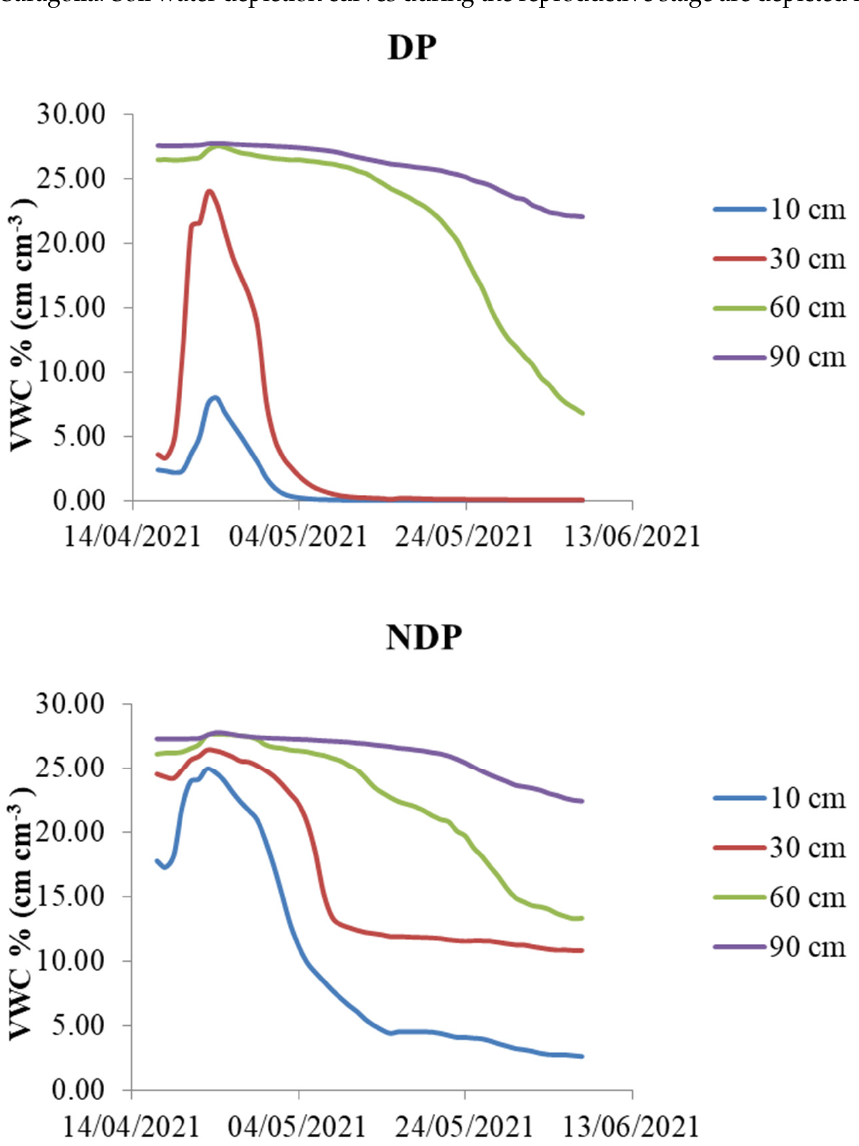
Figure 5. Volumetric water content % (VWC cm cm − 3 ) during the reproductive stage under dual- purpose (DP) and conventional (NDP) management at the four soil depths where the probes were installed (10 cm, 30 cm, 60 cm, 90 cm).